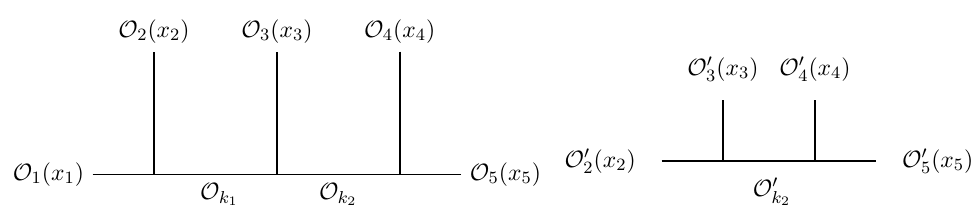
Figure 25 . The 5 -point and 4 -point blocks, respectively. The 4 -point topology is obtained by removing the O ( x ) 1 1